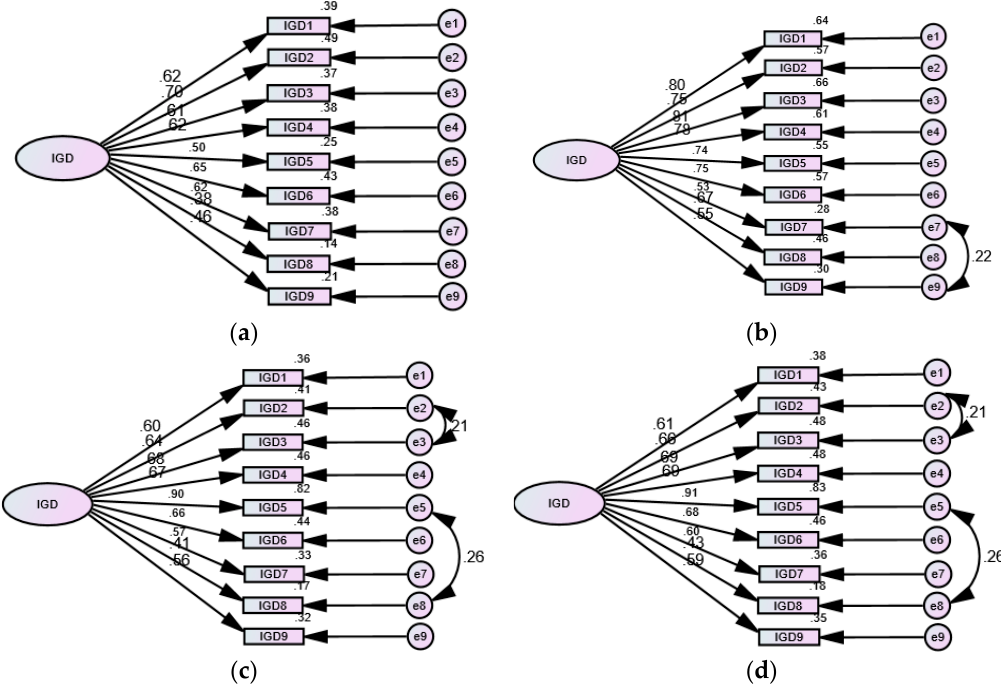
Figure 1. Factor structure of the Internet Gaming Disorder 9—Short Form (IGDS9-SF) among participants from Sri Lanka ( a ), Turkey ( b ), Australia ( c ), and the USA ( d ).